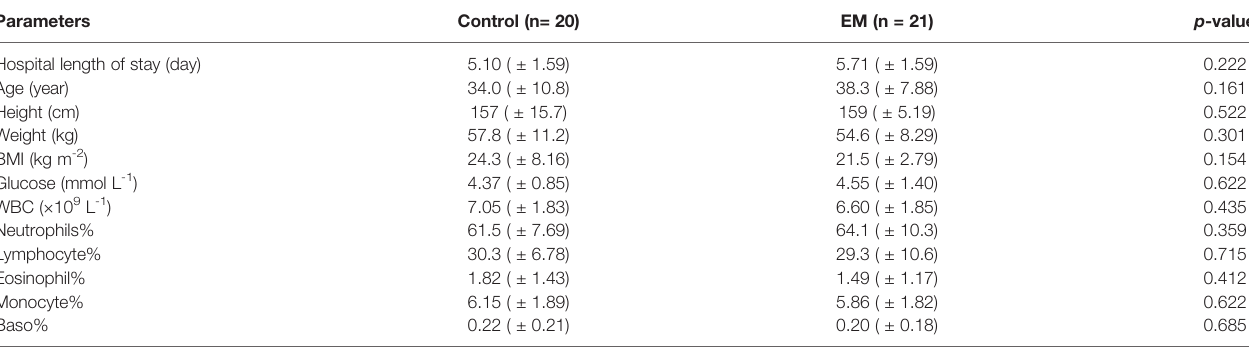
BMI, body mass index; WBC, white blood cell; Baso, basophilic granulocyte. Data were expressed as mean ± SD. p-value denotes two-tailed Student ’ s